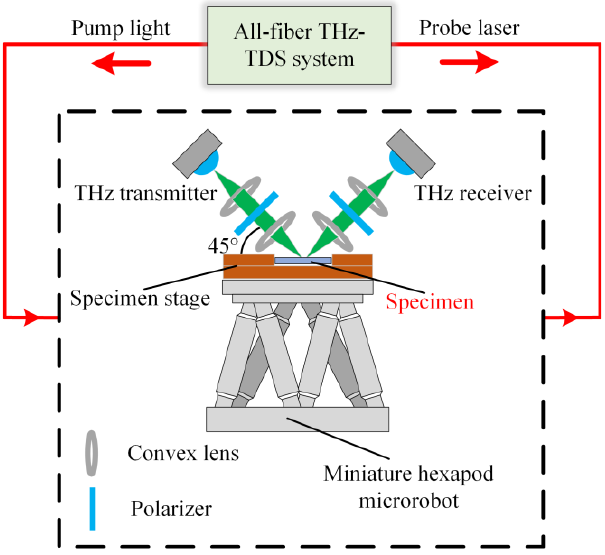
Figure 2. Schematic of the TBC internal stress characterization system.